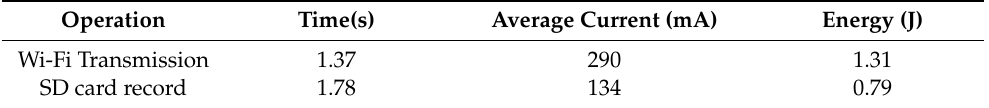
Table 6. Energy for image save or